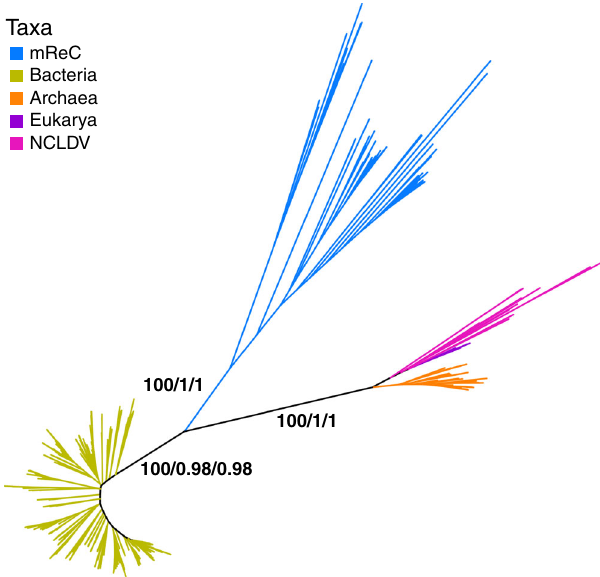
Fig. 2 Unrooted phylogeny of concatenated RNAP β and RNAP β ′ amino acid sequences. Homologs of β and β ′ used for Eukarya were RPB2 and RPB1, and homologs B and A in Archaea, respectively. Phylogeny was constructed from the concatenated alignment of RNAP β and β ′ of 589 taxa constructed using maximum likelihood with the amino acid substitution model LG + C60 + F + Γ 4. Branch color corresponds to taxonomic group. Branch support values are from the left to right: ultrafast bootstrap from 1000 replicates reported as a proportion out of 100, relative Internode Certainty (IC) out of 1, absolute IC out of 1. Instructions for accessing full trees with support values can be found in the “ Data Aavailability ”